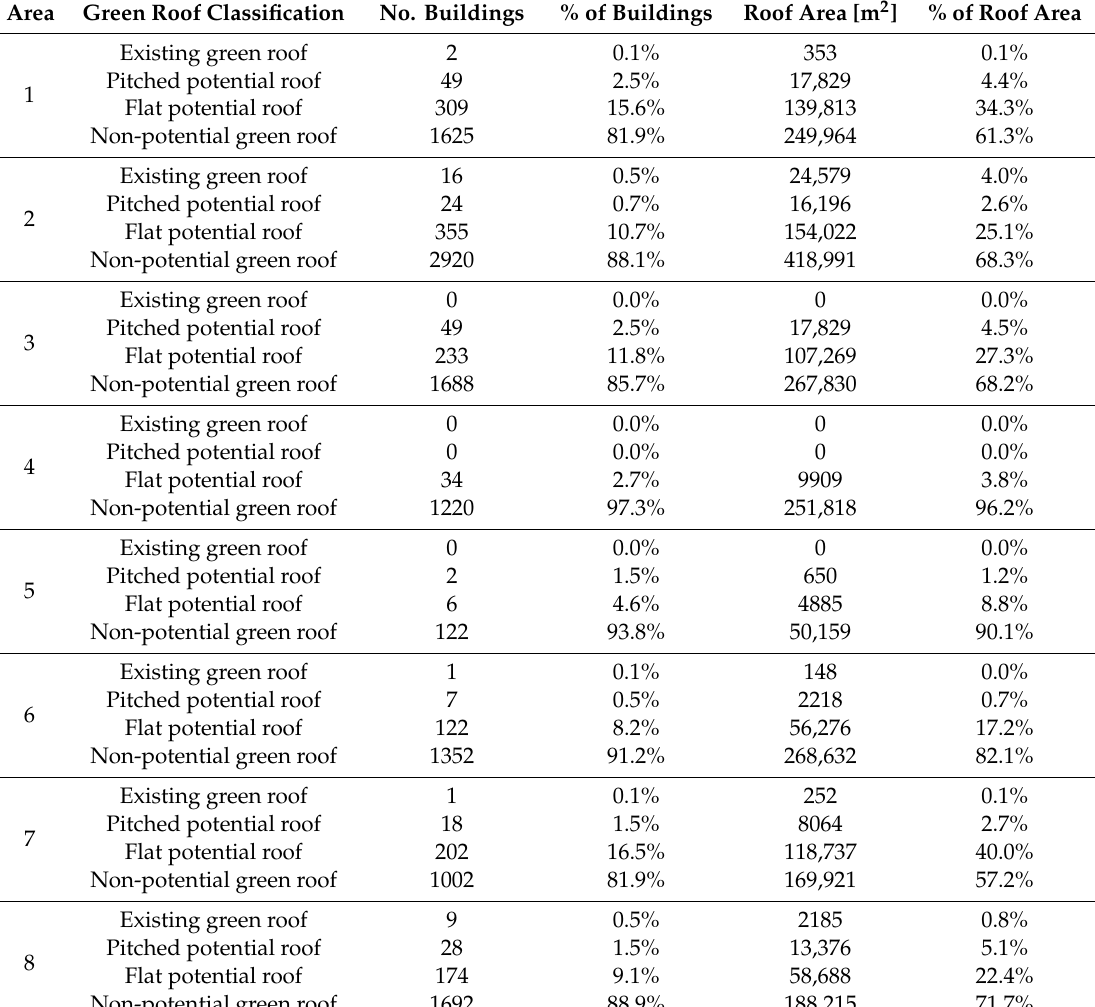
Figure 16. Identification of the existing and potential green roofs in eight areas of Turin. Table 9. Identification of existing and potential green roofs in the eight areas of Turin.